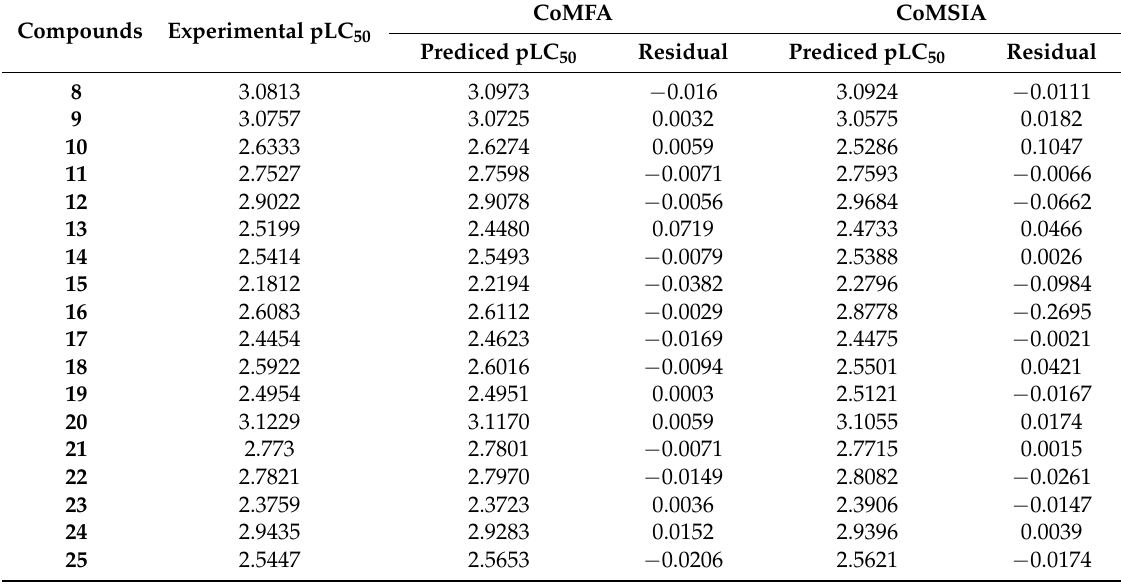
Table 7. Experimental and predicted acaricidal activities (pLC 50 , mol/L) from 3D-QSAR of the compounds 8 – 37